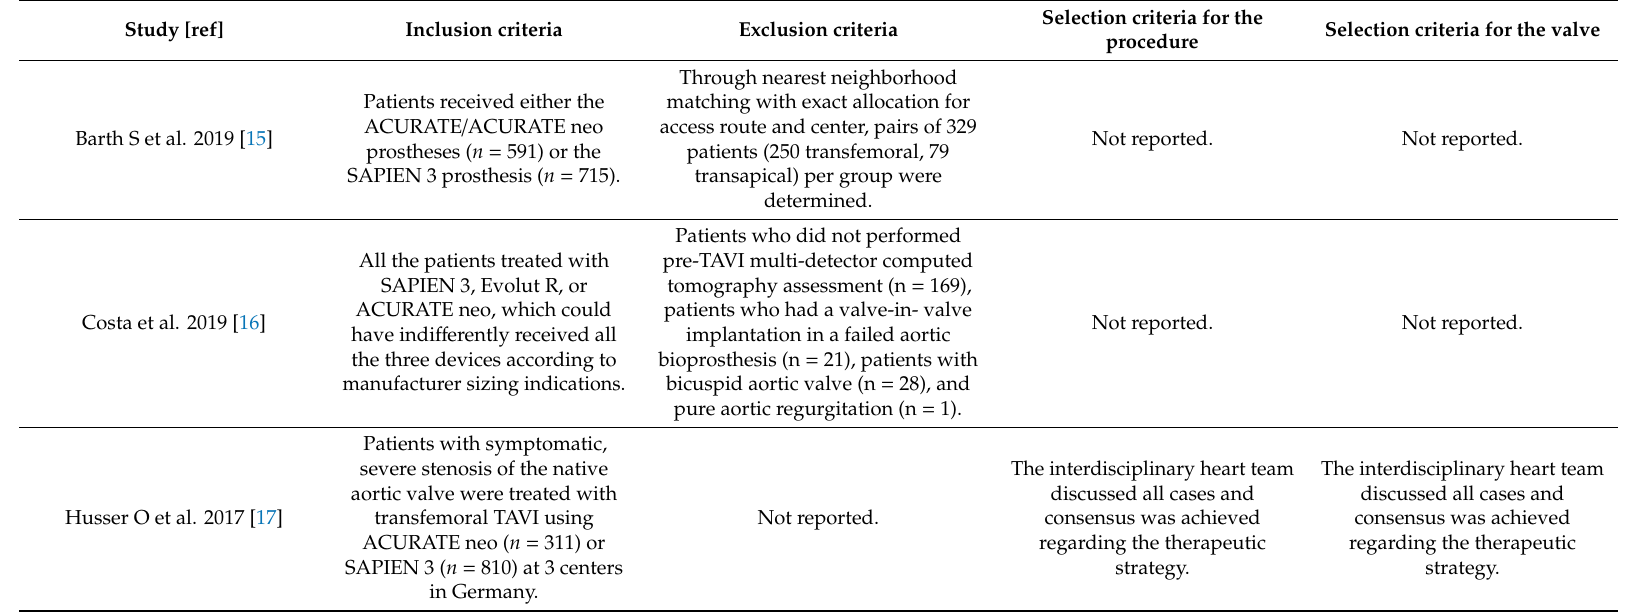
Table A3. Inclusion and exclusion criteria. Choice of procedure and